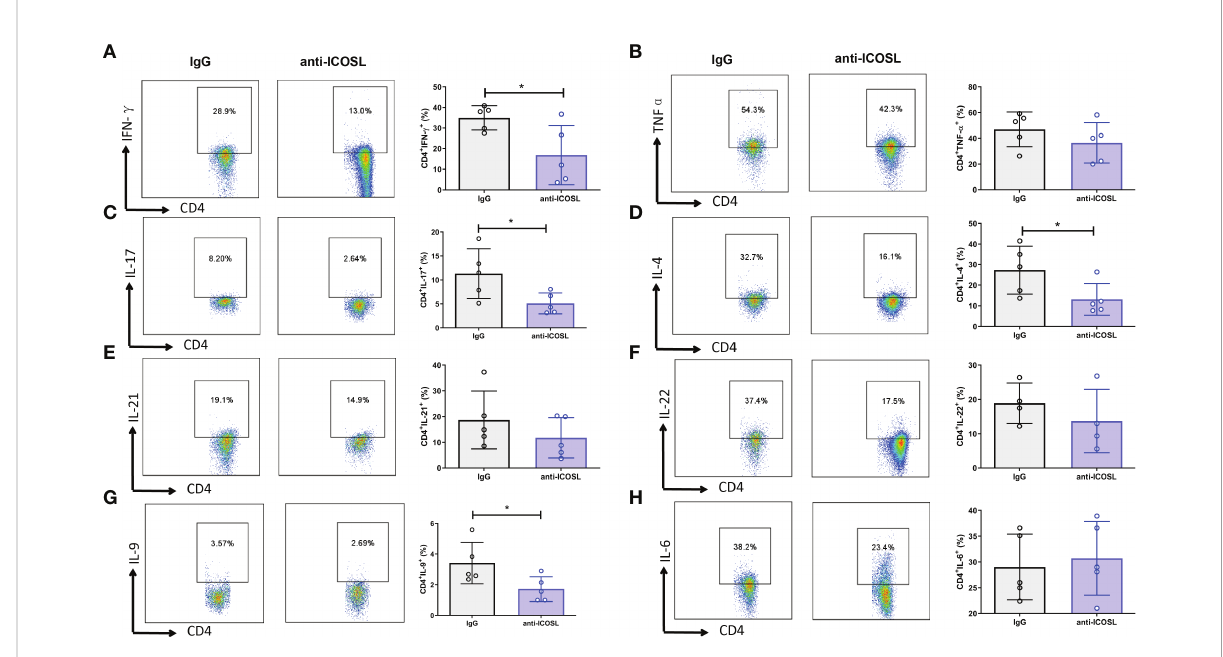
FIGURE 10 Cytokine secretion of the splenocytes from CIA mice treated with anti-ICOSL mAb (n = 5) or IgG (n = 5). (A) The secretion of IFN- g by CD4 + T cells. (B) The secretion of TNF- a by CD4 + T cells. (C) The secretion of IL-17 by CD4 + T cells. (D) The secretion of IL-4 by CD4 + T cells. (E) The secretion of IL-21 by CD4 + T cells. (F) The secretion of IL-22 by CD4 + T cells. (G) The secretion of IL-9 by CD4 + T cells. (H) The secretion of IL- 6 by CD4 + T cells. Bars show mean ± SD; * P <